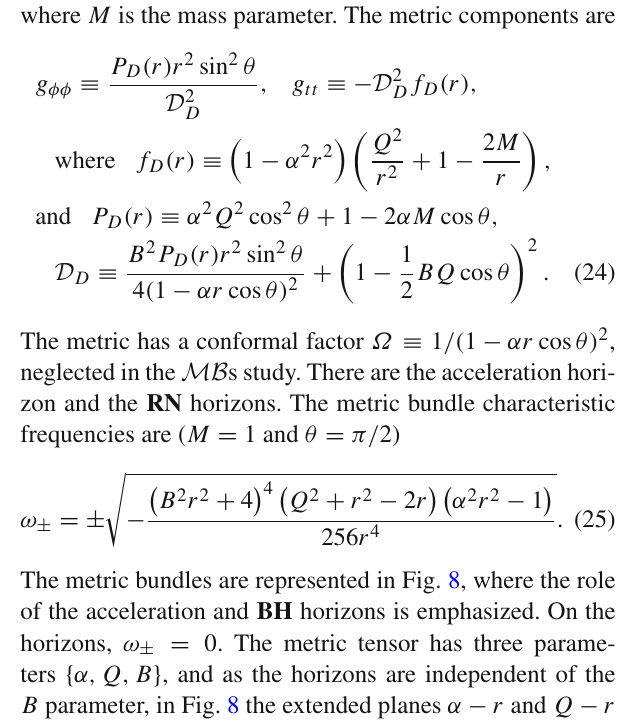
Fig. 8 Ernst solution of Eq. (24) for θ = π/ 2. Metric bundles are rep- resented in the plane α − r (upper line panels) and Q − r (bottom line panels) for different values of the metric parameters, where the mass parameter is M = 1, B is a parameter representing the electromagnetic